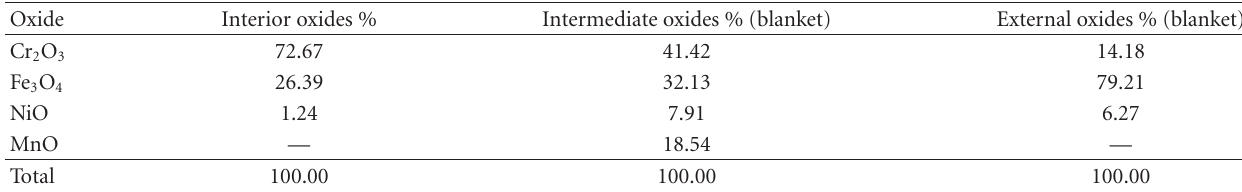
Table 5: EDX spectra analysis of the oxides in di ff erent areas for AISI 316 at T = 1000 ◦